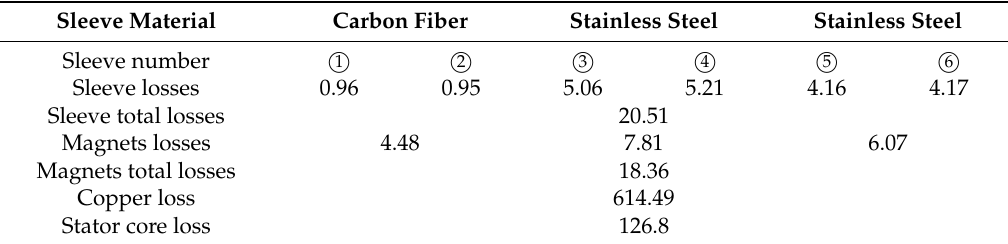
Table 6. Losses in different parts of PMSM under Design 1 (W).